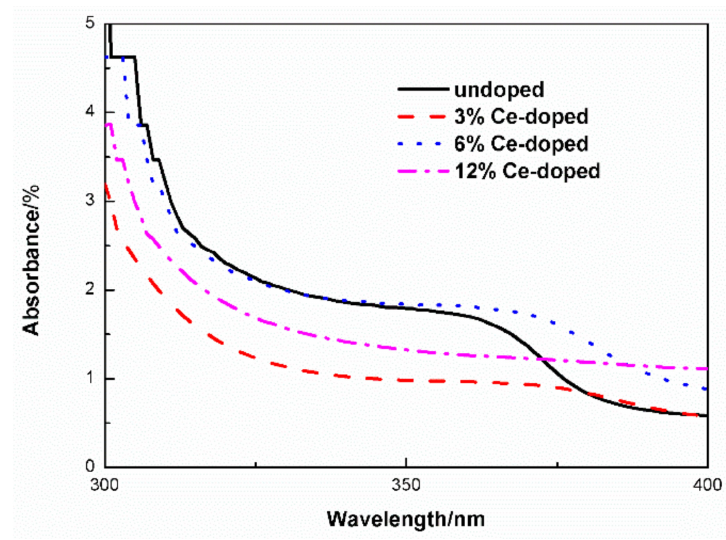
Figure 5. UV-vis absorbance of un-and Ce-doped ZnO films.